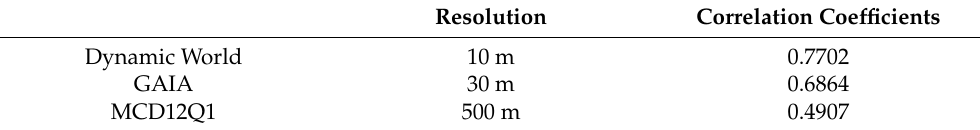
Table 7. Correlation coefficients ( R 2 ) between our results and other thematic related